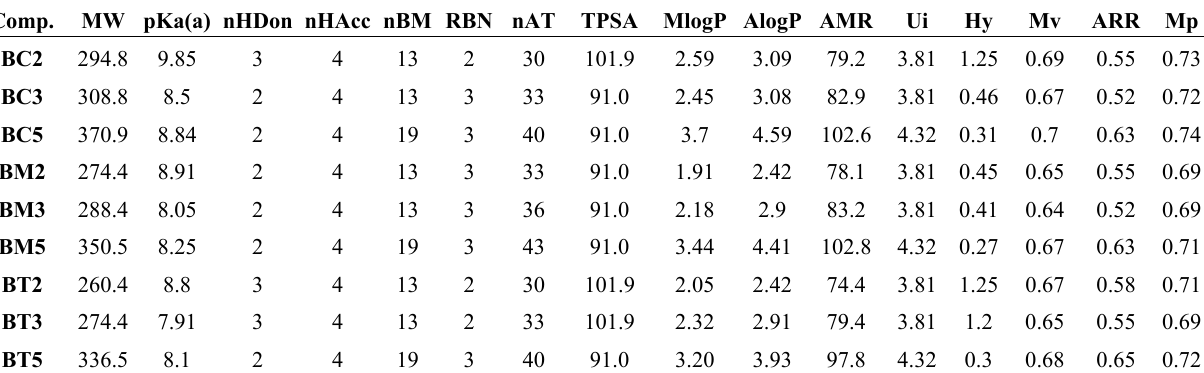
Table 1. Values for the selected molecular descriptors.